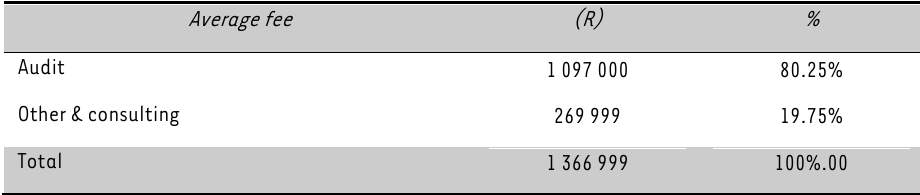
TABLE 7: Auditing fees